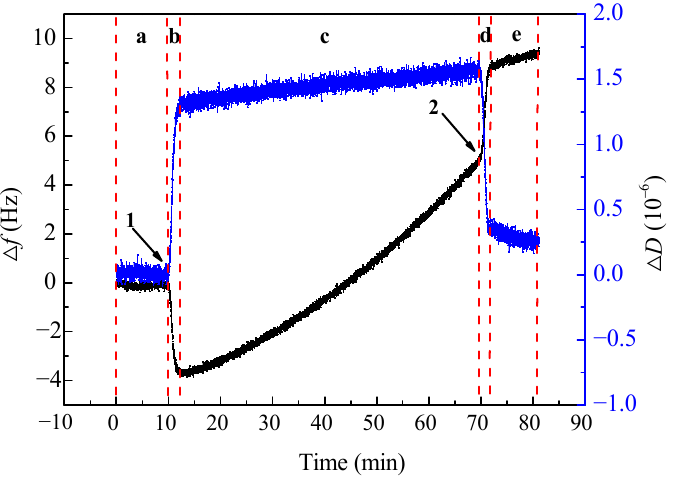
Figure 10. Frequency shift ( ∆ f ) and dissipation shift ( ∆ D ) vs. leaching time at 1 mmol/L PF, pH = 12. a, b, c, d and e represent the initial, adsorption, leaching, desorption and flushing stages. 1 and 2 indicate PF solution and deionized water enter the system, respectively.